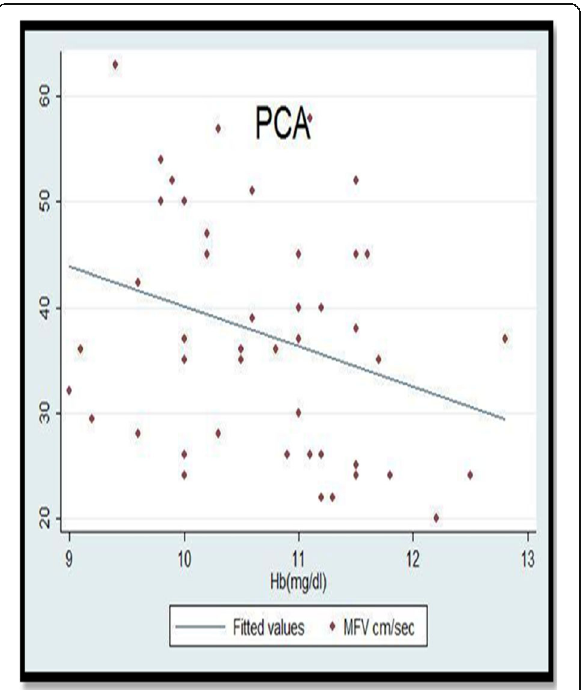
Fig. 2 Correlation between PCA score and hemoglobin level ( P <